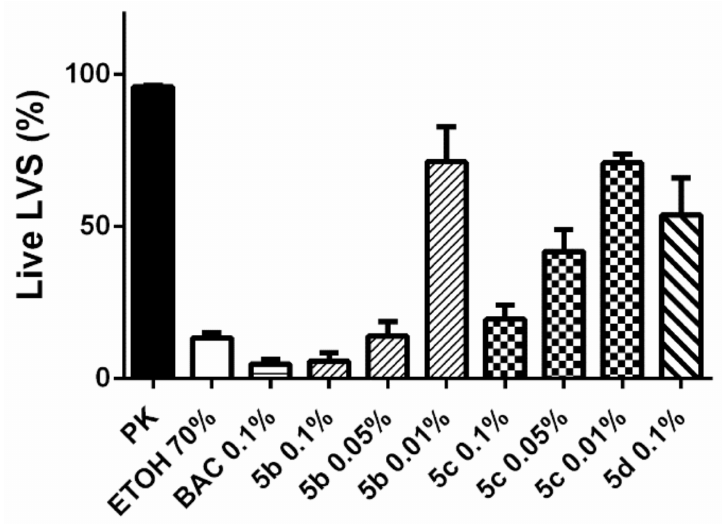
Figure 5. Susceptibility testing against Francisella tularensis LVS. The remaining ratio of living LVS after 5 min exposure is expressed as mean ± SEM ( n = 3).